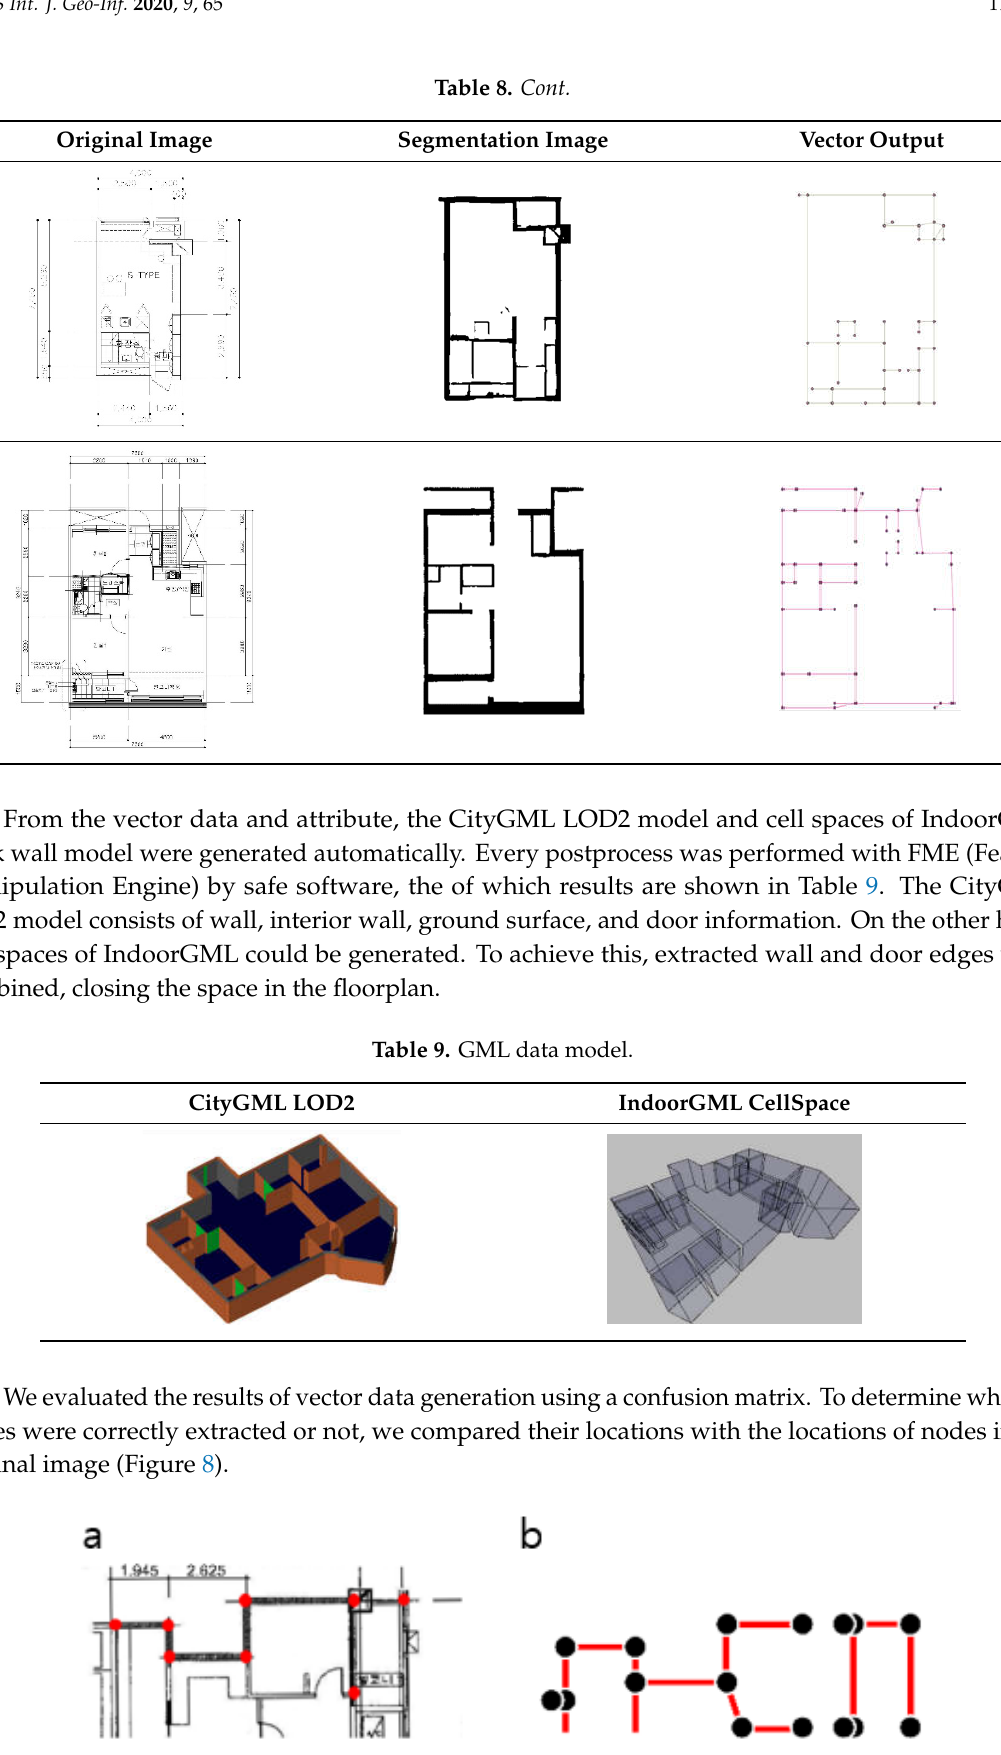
Figure 8. Comparison of ( a ) nodes generated by ground truth with ( b ) extracted nodes.